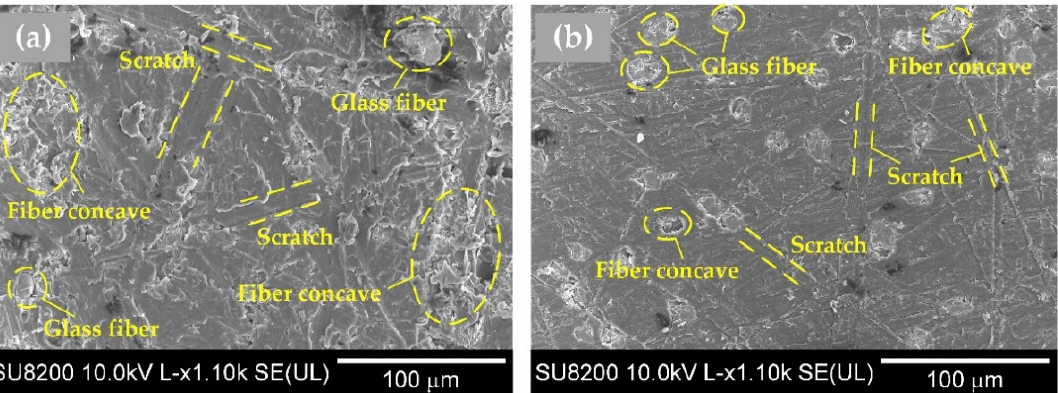
Figure 10. Surface morphology lapped with the #1000 mesh size silicon carbide abrasive paper of glass-fiber-reinforced PEEK materials with different glass fiber mass fractions, ( a ) glass-fiber-reinforced PEEK with 10% glass fiber mass fraction; ( b ) glass-fiber-reinforced PEEK with 30% glass fiber mass fraction.